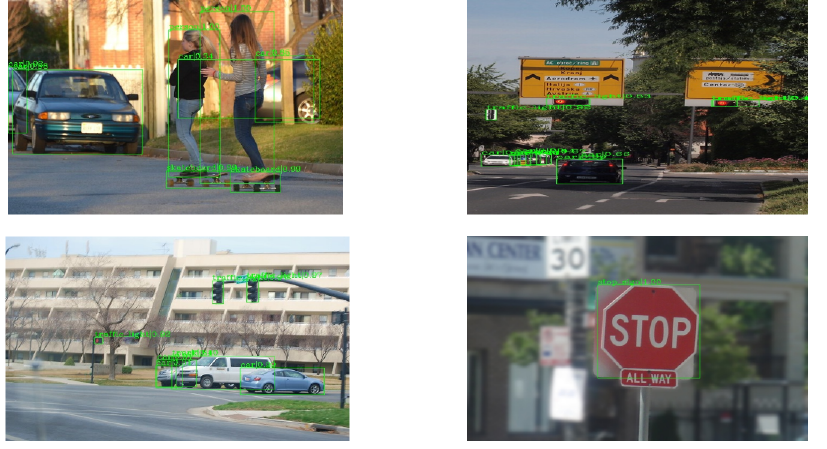
Figure 4. vePOD Faster R-CNN achieves the same detection accuracy as Faster